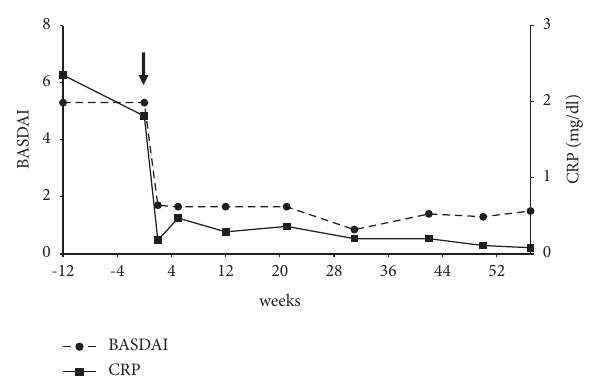
Figure 2: Changes over time in BASDAI and CRP during the therapy with Brodalumab. At 0weeks, subcutaneous injection of Brodalumab 210mg was initiated (arrow) and repeated weekly for two weeks. After loading, it was maintained by injection every two